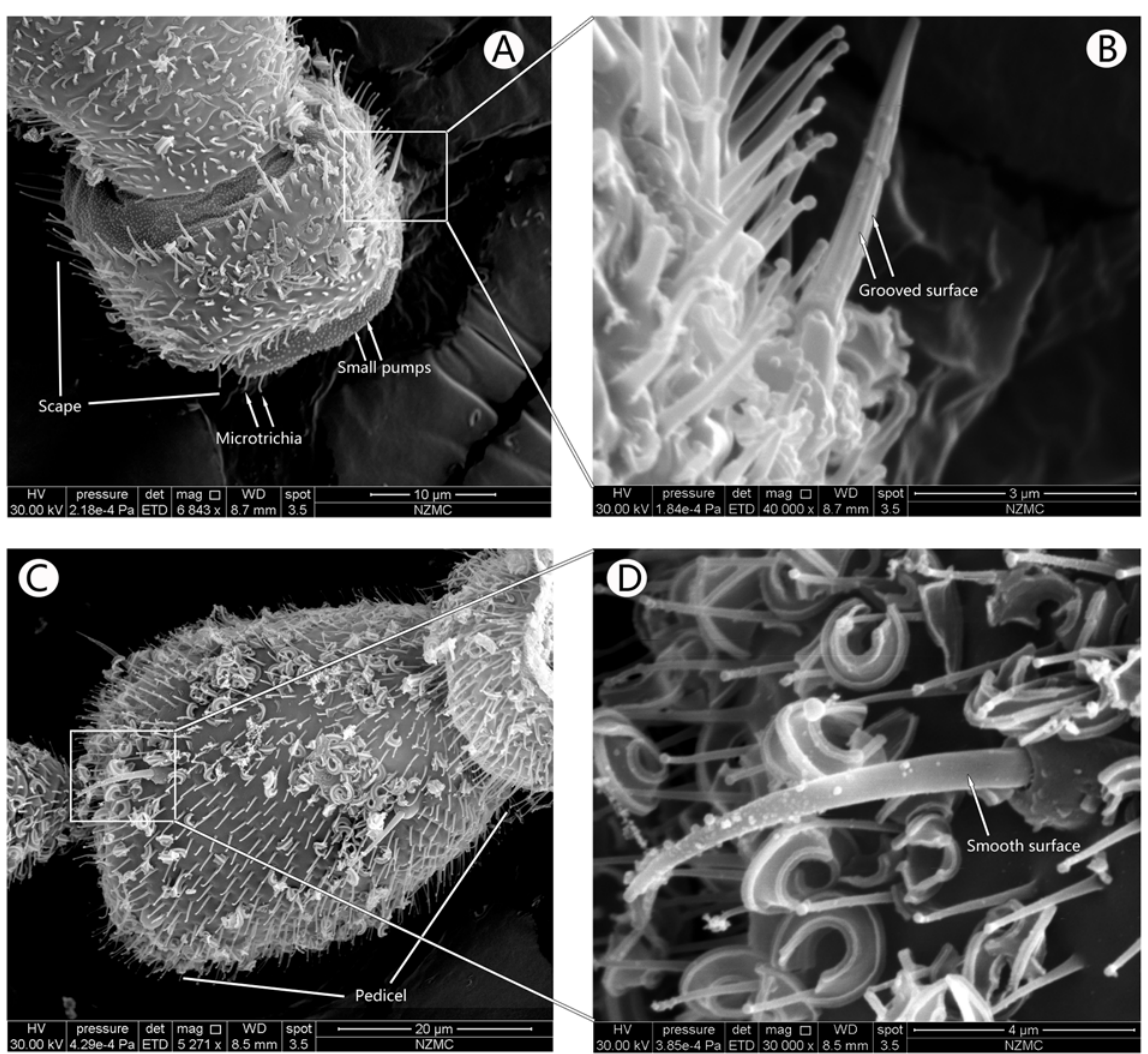
Fig 5. Ventral surface of the scape and pedicel. Scape (A) and Grooved surface trichodea sensilla (B) in MEAM1 male, which has grooved surface. Ventral surface of the bulbous pedicel, showing the Chaetae sensilla with smooth surface in MEAM1 female (C,